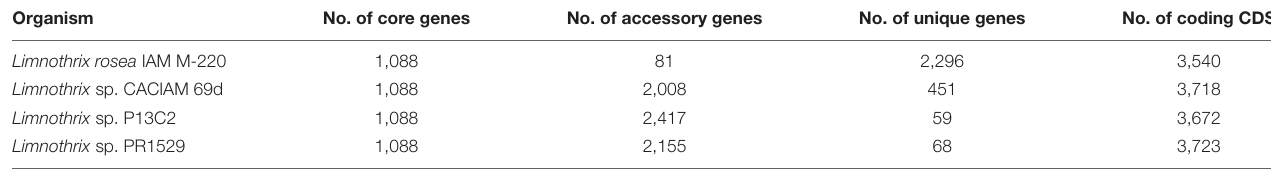
TABLE 2 | Number of protein sequences for representatives of core, accessory and unique orthologous clusters present in all four Limnothrix genomes. Organism No. of core genes No. of accessory genes